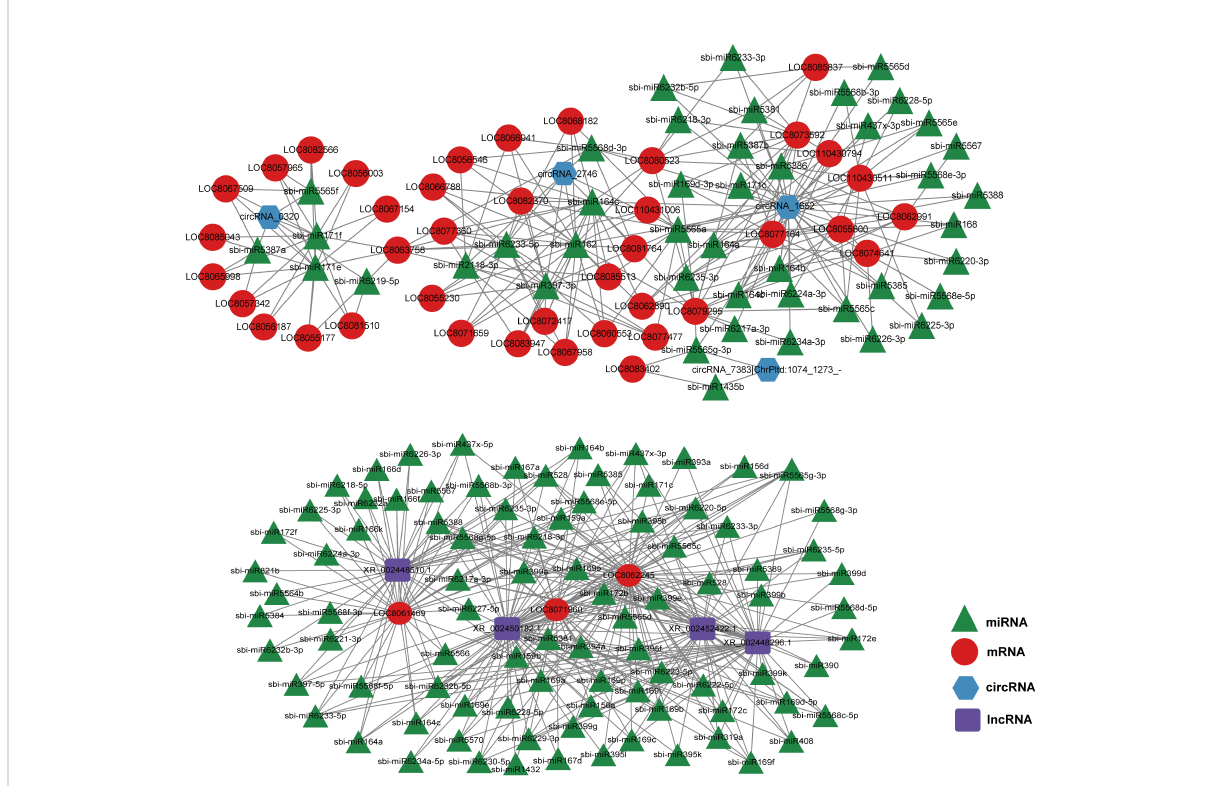
FIGURE 7 Competitive endogenous RNA (ceRNA) network generated using the differentially expressed (DE)-mRNAs, DE-lncRNAs, DE-circRNAs, and DE- miRNAs in sorghum ( “ Jitian 3 ” ) between GL_A and GL_B groups. Red, blue, and green represent lncRNA, miRNAs, and mRNAs, respectively. ceRNA network was conducted by Cytoscape software